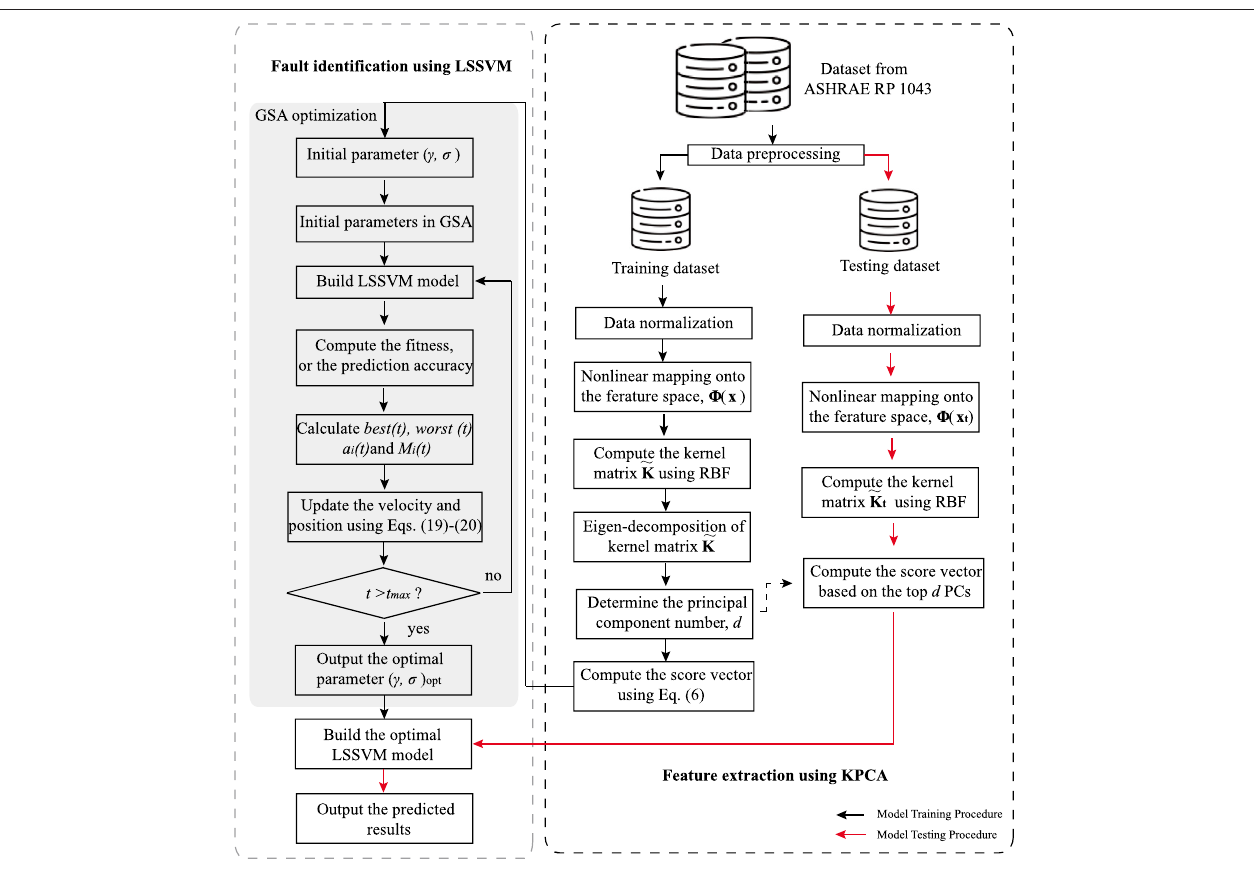
FIGURE 1 | Structure of the proposed fault diagnostic